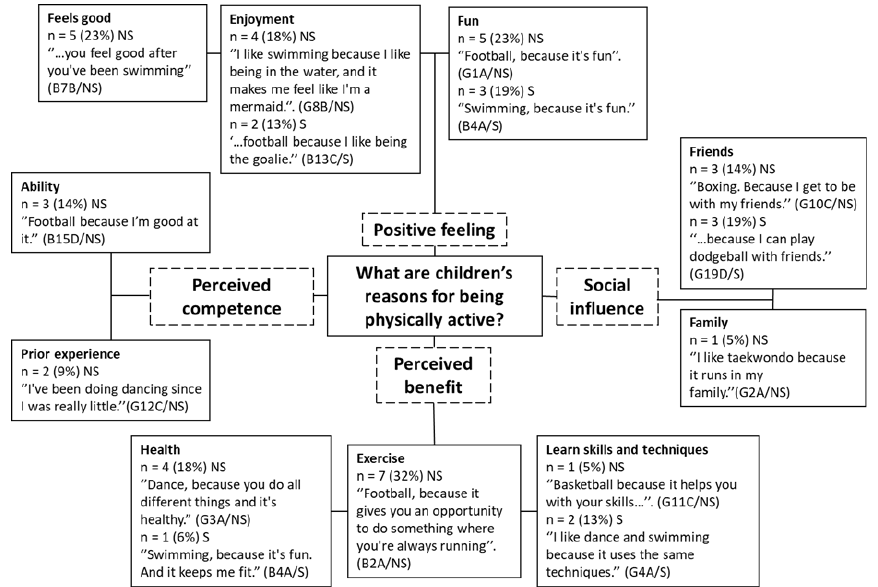
Figure 1. Pen profile demonstrating children’s reasons for being physically active for children from non-smoking (NS) homes and smoking (S) homes. Percentages represent the proportion of each group that contributed to the theme for children from smoking ( n = 16) and non-smoking homes ( n = 22).